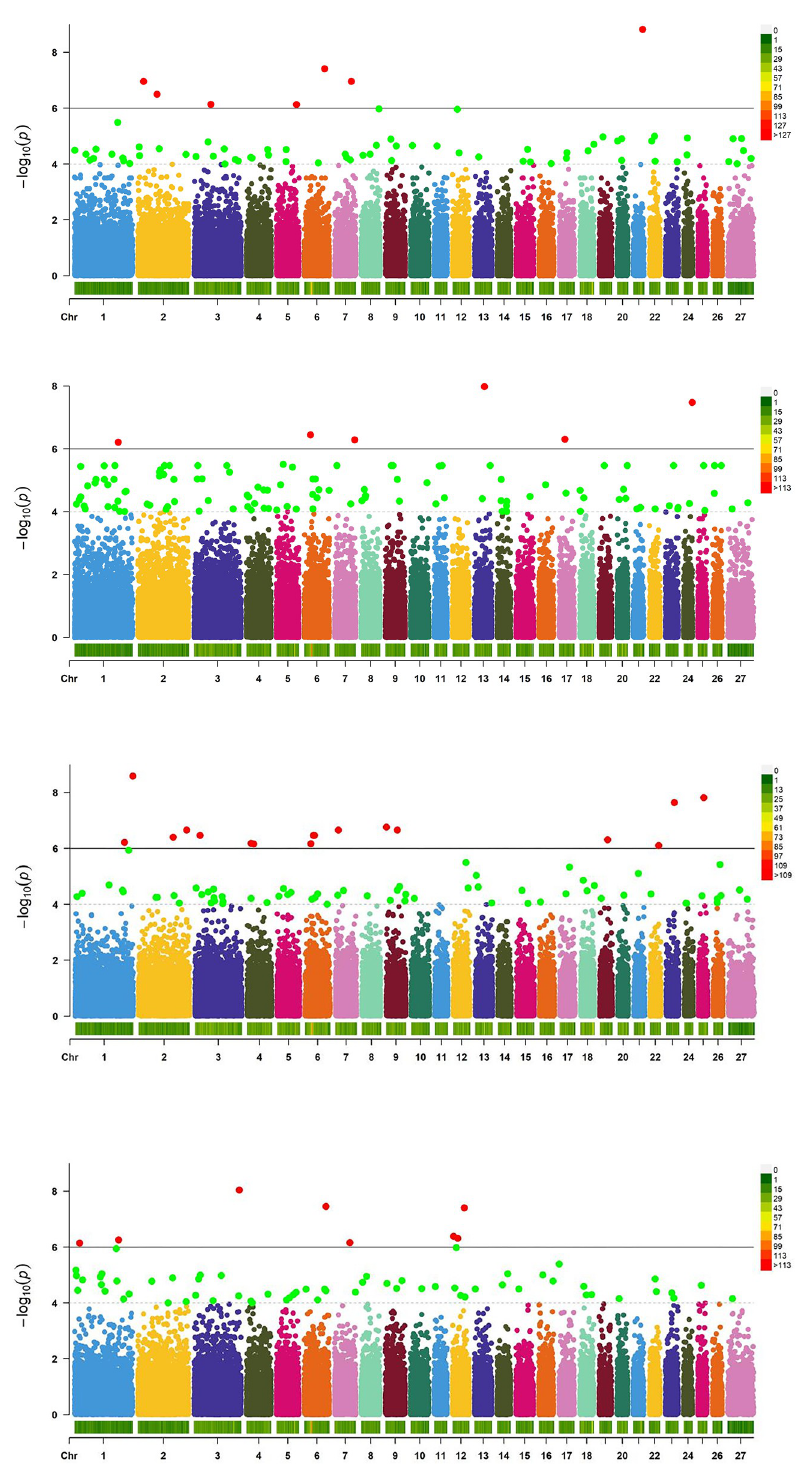
Fig 3. Manhattan plot of Genome-wide association analysis of growth traits between Qira Black sheep and German Merino sheep. Note: A for Body length; B for Body height; C for Body weight; D for the chest circumference. The horizontal red line in the figure represents the Genome-wide significance level threshold, and SNPs located above the red line indicate reaching the Genome-wide significance level.